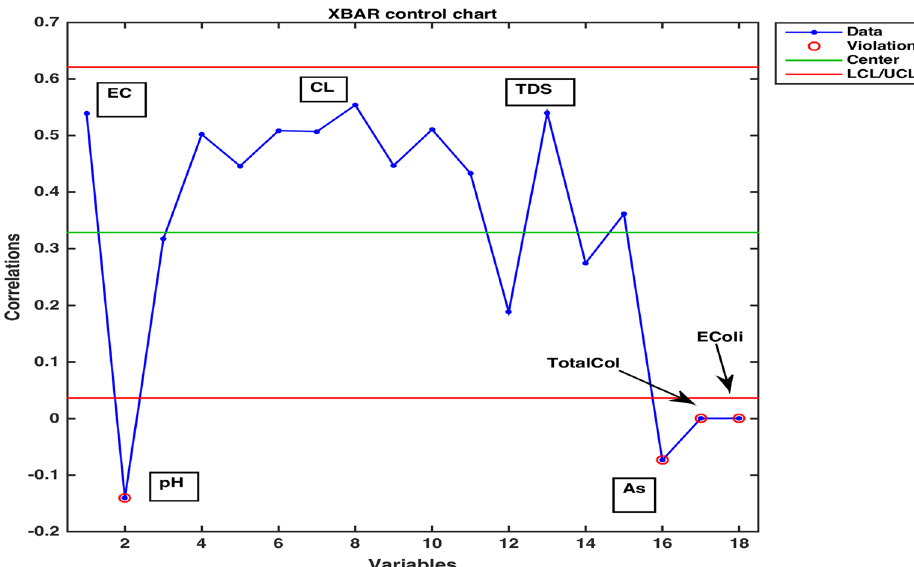
Figure 4. A display of peaked and based